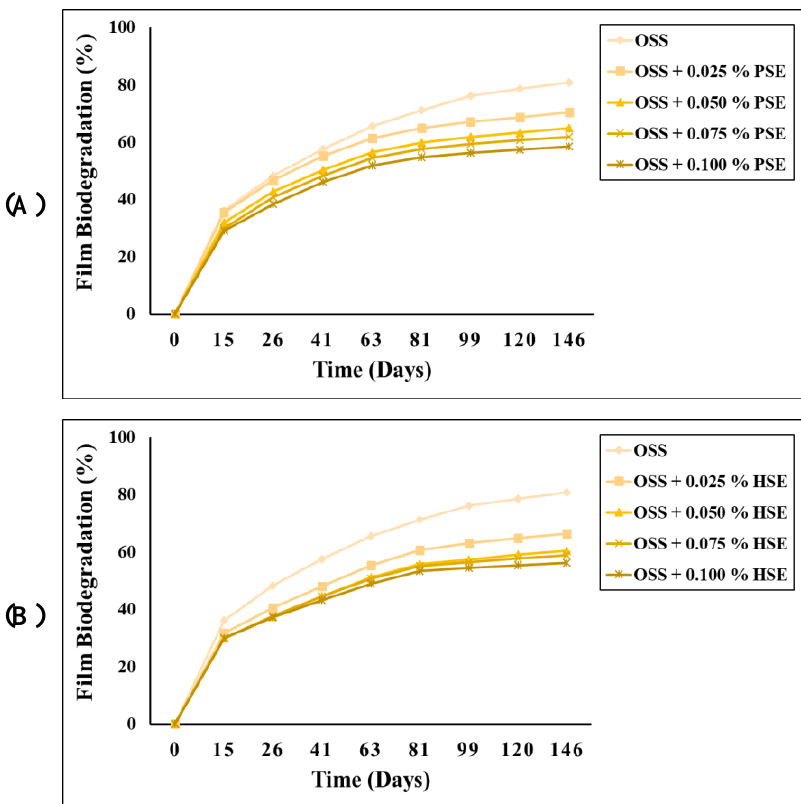
Figure 3. Biodegradability of octenyl succinate starch films with pecan nutshell extract ( A ) and octenyl succinate starch films with hazelnut skin extract ( B ) films. OSS: Octenyl succinate starch, PSE: pecan nutshell extract, HSE: hazelnut skin extract.